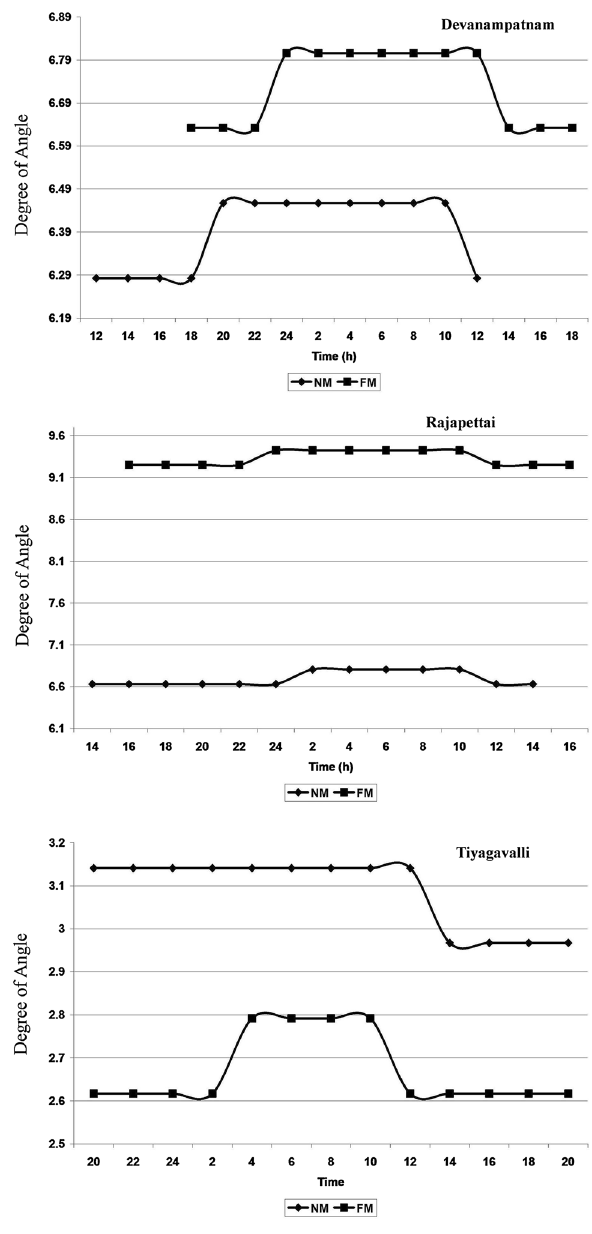
Fig. 11 Inclination of the water level to the mean sea level during FM and NM at Devanampatnam, Rajapettai and Tiyagavalli (in